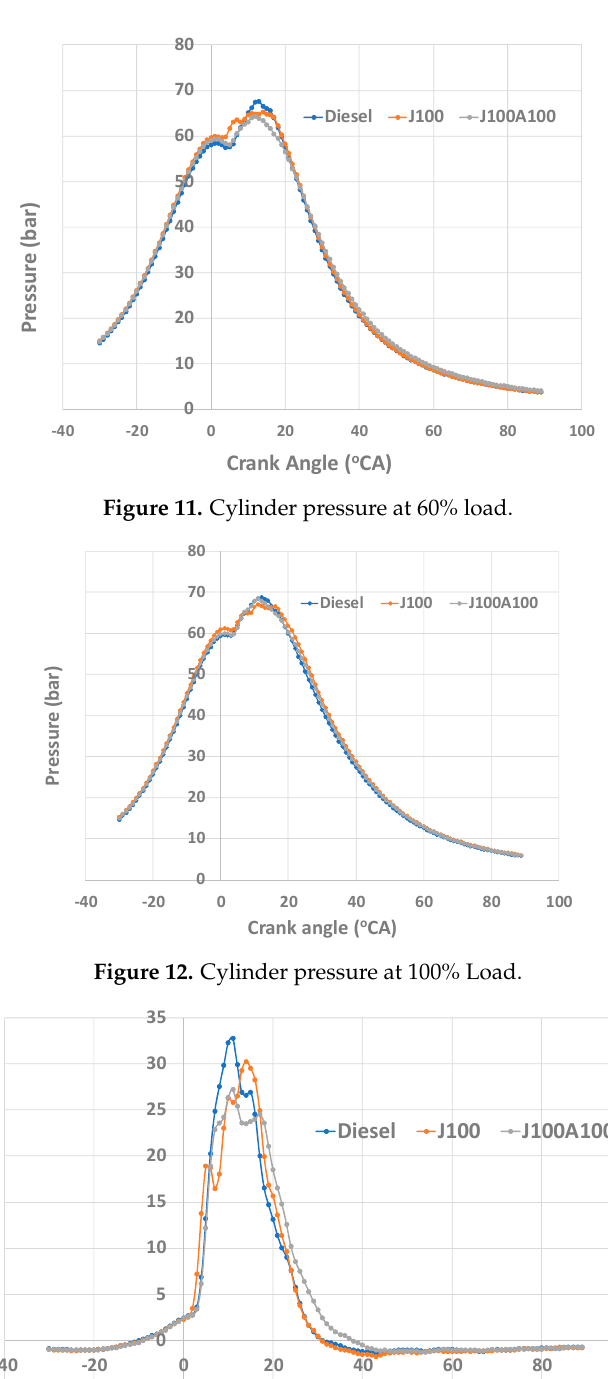
Figure 14. Heat release rate at 100% load. Figure 15. Total heat release at 60% load.